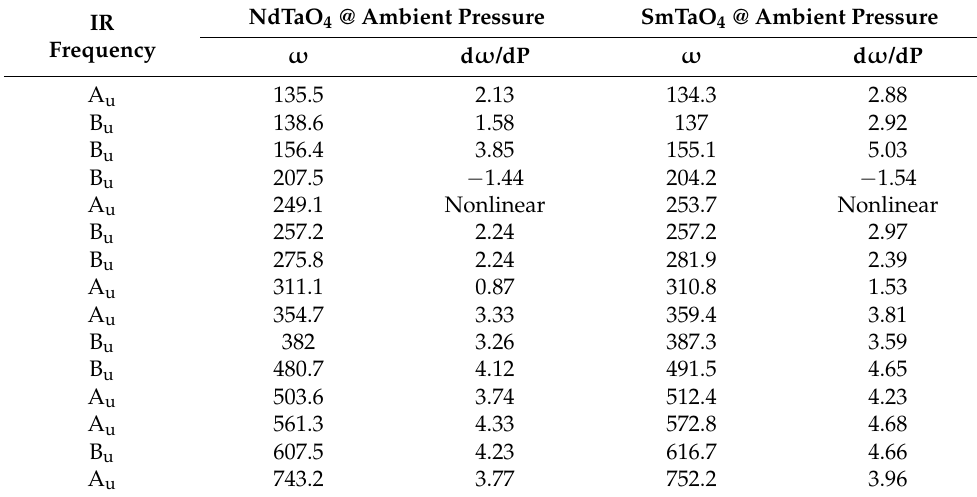
Table 4. Calculated IR modes for NdTaO 4 and SmTaO 4 at ambient pressure along with their pressure coefficients (present